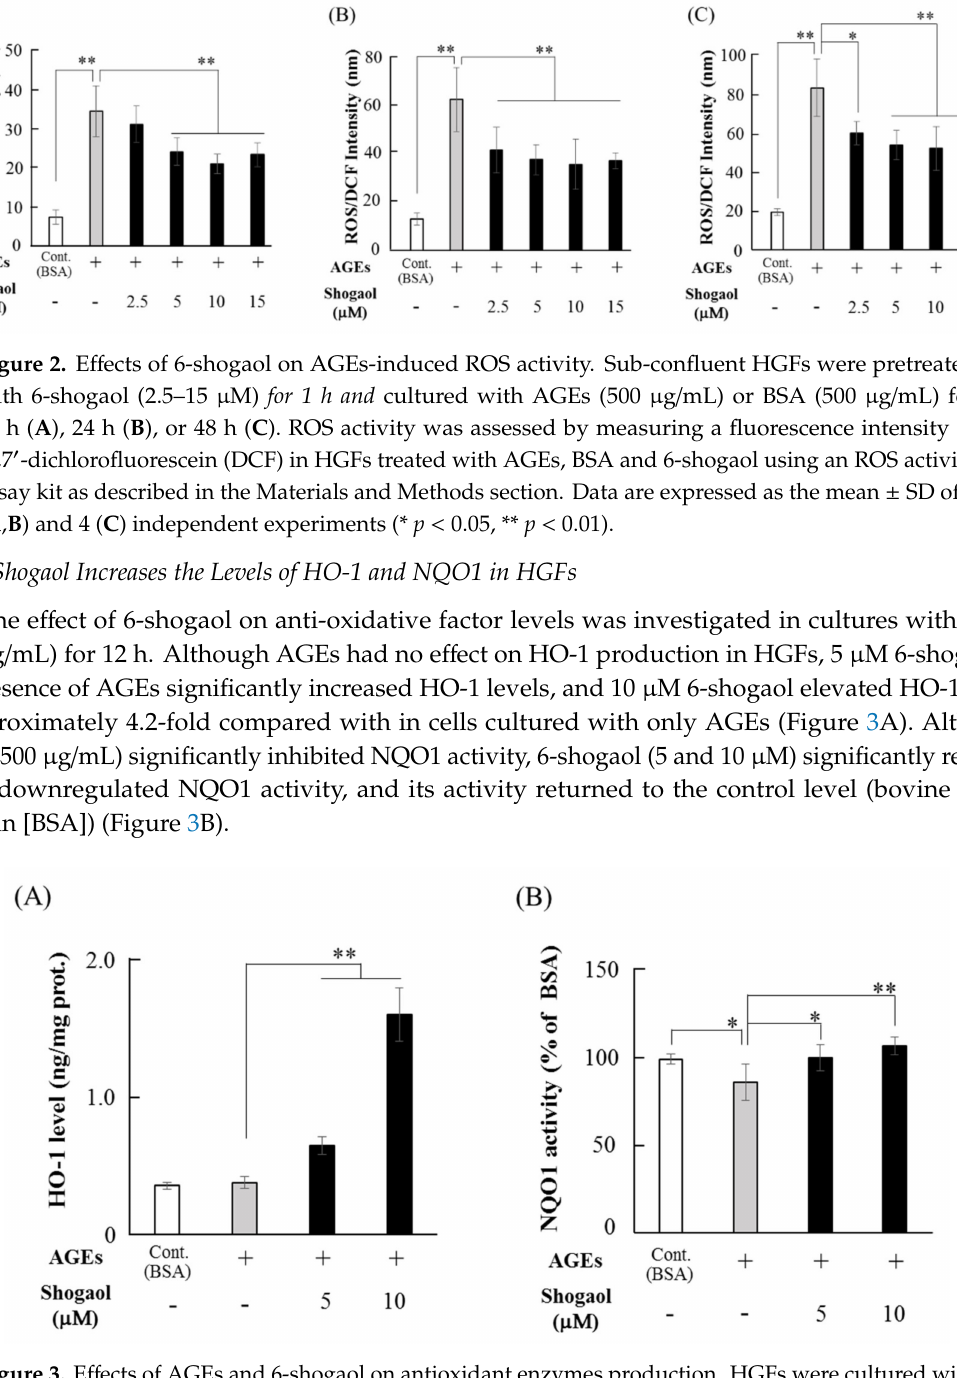
Figure 3. E ff ects of AGEs and 6-shogaol on antioxidant enzymes production. HGFs were cultured with AGEs (500 µ g / mL) or BSA (500 µ g / mL) for 12 h after pre-treatment with 6-shogaol (5 or 10 µ M) for 1 h. ( A ) HO-1 levels in the cell lysate of treated HGFs were assessed using ELISA. ( B ) NQO1 levels in the cell lysate were assessed using an NQO1 activity assay kit, as described in the Materials and Methods section. Data are expressed as the mean ± SD of 6 ( A ) and 5 ( B ) independent experiments (* p < 0.05, ** p <